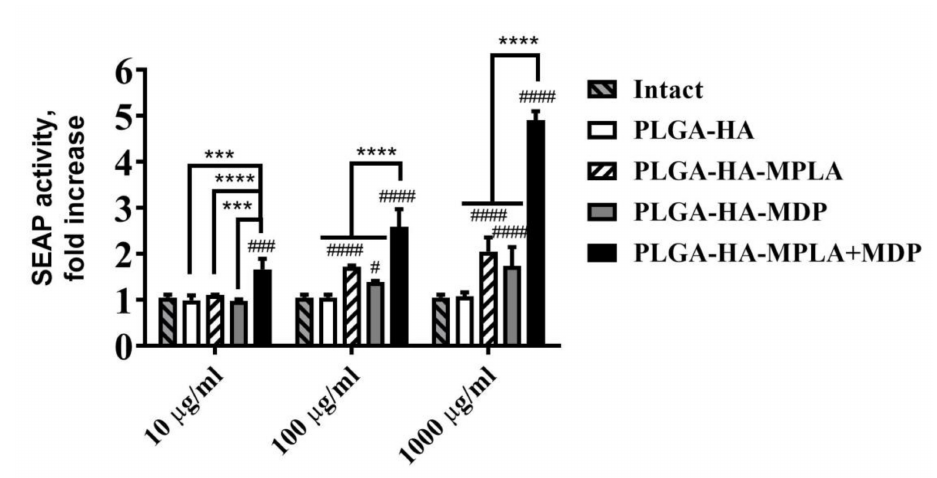
Figure 1. The potentiation of NF- κ B / AP-1-dependent secreted embryonic alkaline phosphatase (SEAP) reporter gene expression is not dampened by the encapsulation of monophosphoryl lipid A (MPLA) and muramyldipeptide (MDP) into poly-(D,L-lactic-co-glycolic acid) (PLGA) NPs. The figure represents NF- κ B / AP-1-dependent SEAP reporter gene expression in RAW-Blue cells treated for 18 h with PLGA NPs without PRR agonists, with individual PRR agonists or their combination, at the indicated doses (on the x-axis). SEAP activity was measured in cell-free culture supernatants 18 h after the addition of PLGA NPs. Bars represent the mean fold increase ± SD (whiskers) in SEAP activity relative to intact (untreated) cells. Experiment was performed in triplicate. The mean value of untreated cells ( = 0.74 ± 0.04 mU / mL) was taken equal to 1 (100%). Significant di ff erences between PLGA NPs with or without pattern-recognition receptor (PRR) agonists are indicated by hashes: # for p < 0.05, ### for p < 0.001 or #### for p < 0.0001. Significant di ff erences between PLGA-HA-MPLA + MDP and PLGA-HA-MPLA or PLGA-HA-MDP are indicated by asterisks and brackets: *** for p < 0.001 or **** for p < 0.0001 (two-way ANOVA post-hoc Dunnett’s